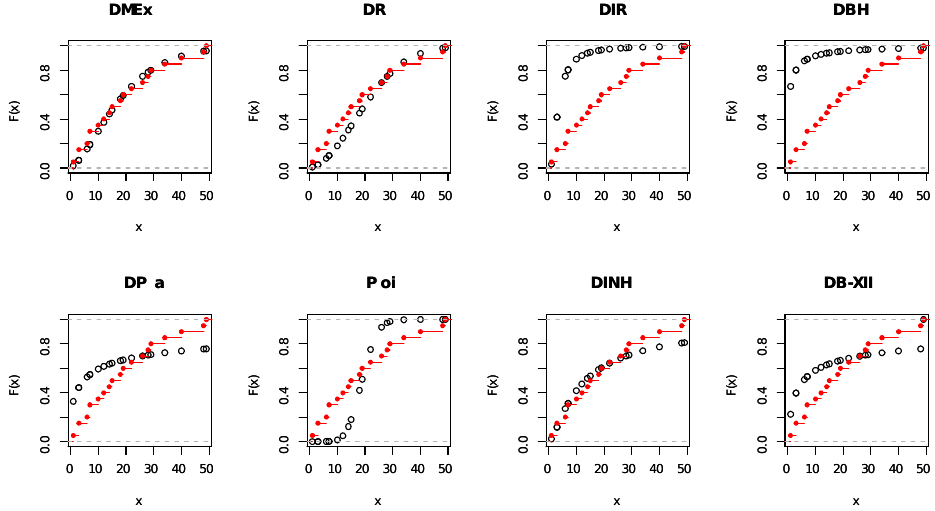
Table 11 . The GOF test for LR data.